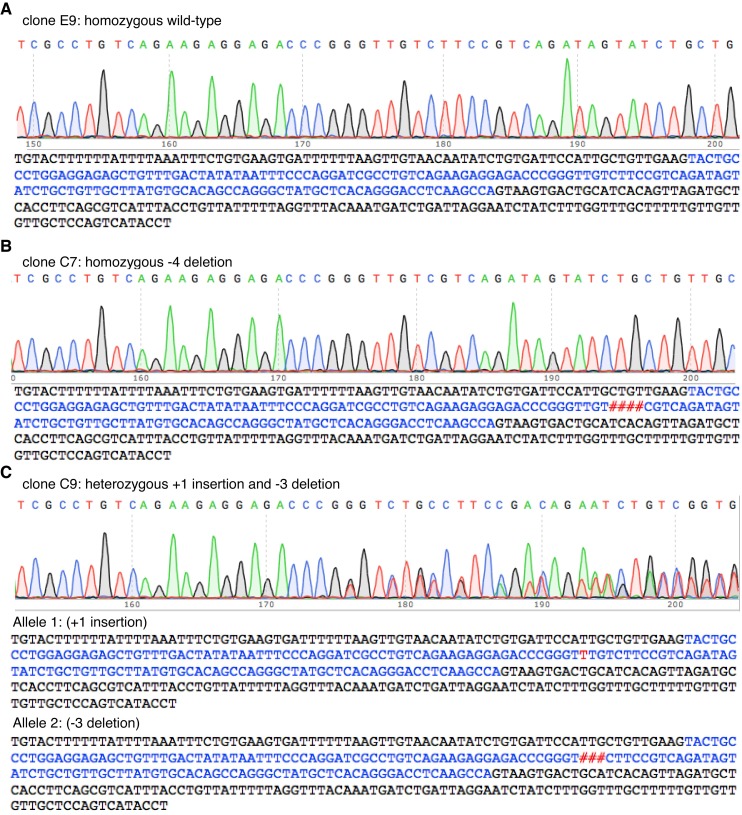
Genotype analysis of cell clones selected from MDA-MB-468 cells transfected with Cas9/sgMELK-3.Trace images of the sequence around exon 5 of MELK and the actual sequences of the PCR amplicons from three clones isolated from MDA-MB-468 cells transfected with Cas9/sgMELK-3, including clone (A) E9, (B) C7 and (C) C9.